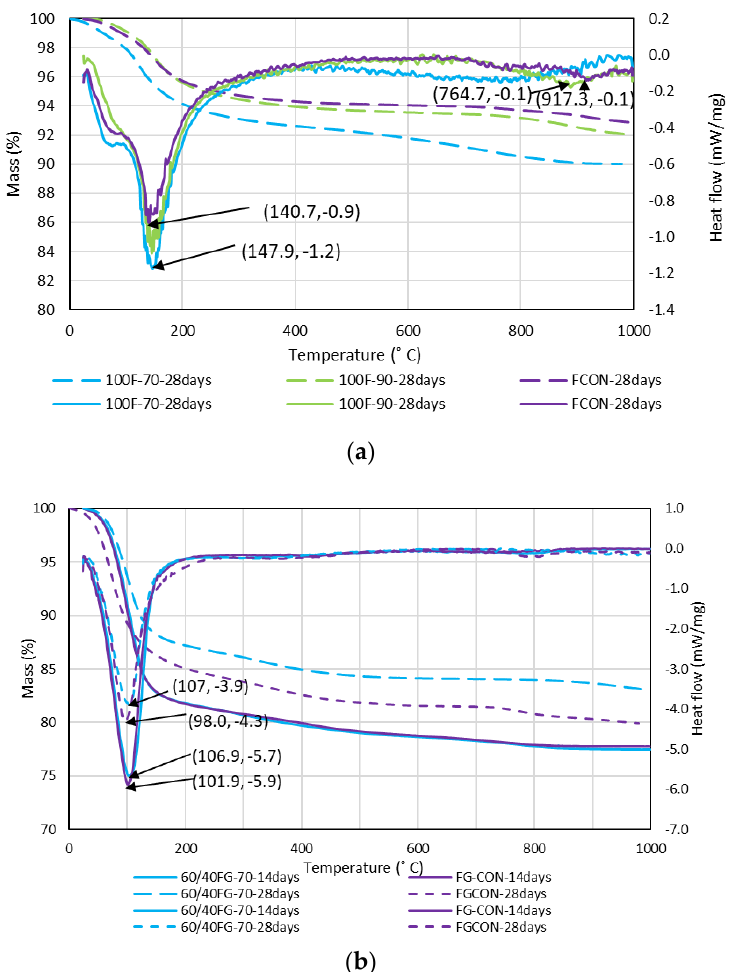
Figure 4. ( a ) TGA of neat fly ash activated with WG-based and commercially available activators at 28 days . ( b ) TGA of 60/40 fly ash/slag activated with WG-based and commercially available activators at 14 and 28 days .